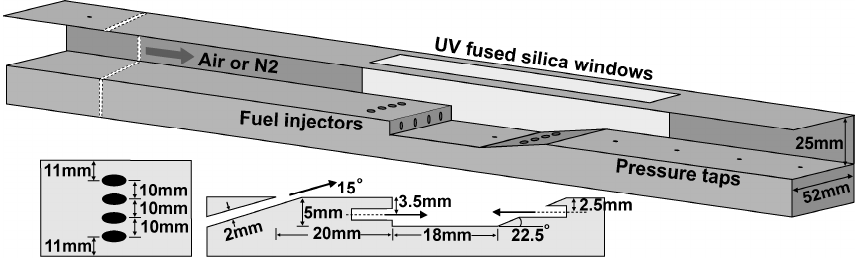
Figure 1. Schematic of cavity scramjet combustor. UV: ultraviolet.